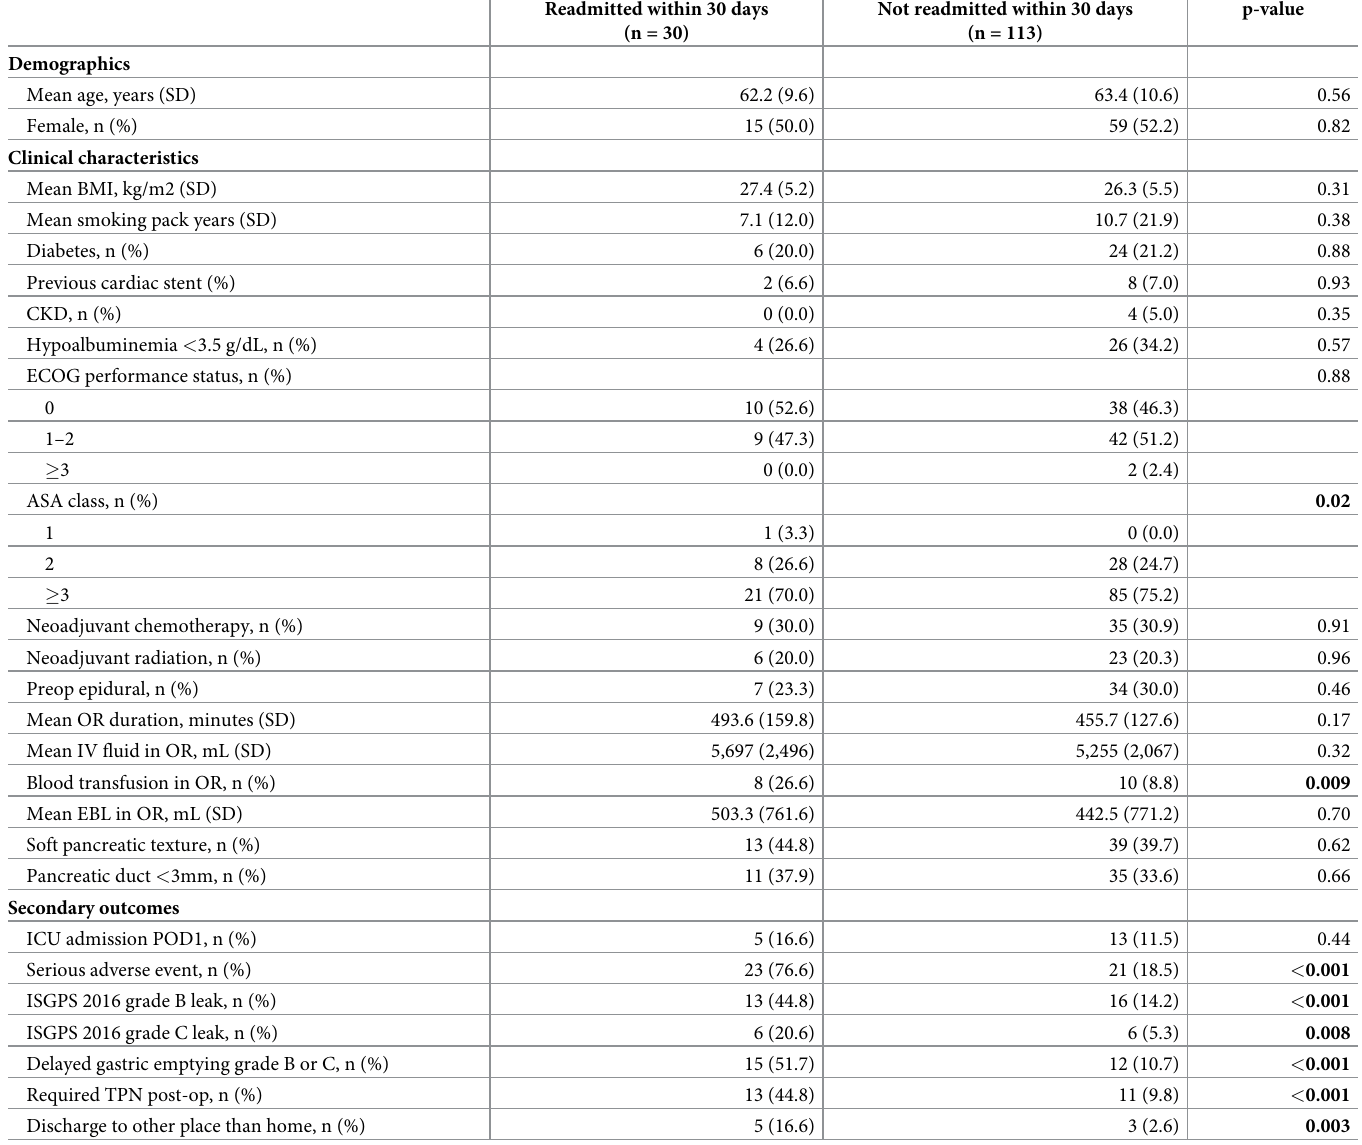
Table 3. Demographics, clinical characteristics, and outcomes of patients readmitted within 30 days of